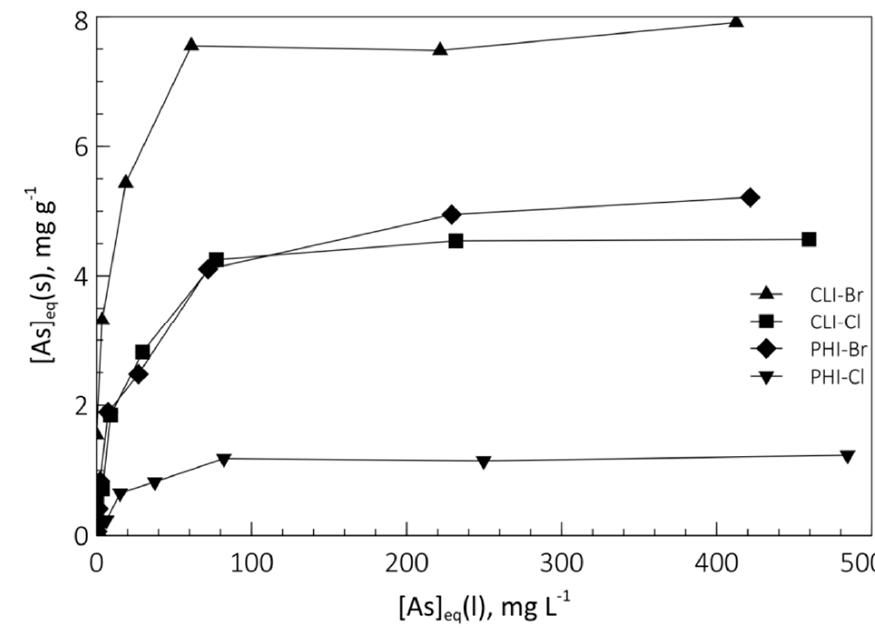
Figure 6. As exchange isotherms for SMNZ samples at a T = 25 ◦ Figure 6 . As exchange isotherms for SMNZ samples at a T = 25 °C.